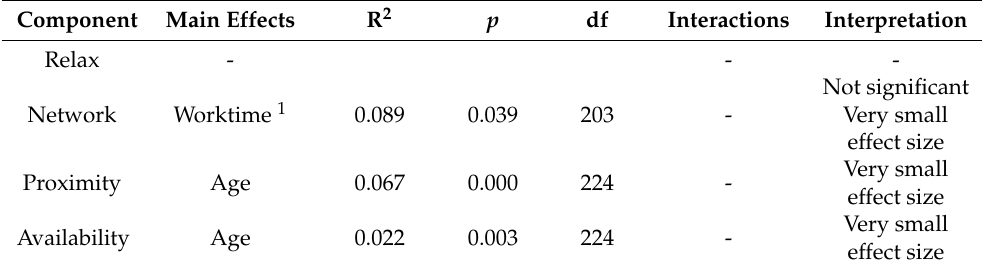
Table 9. Services—Linear regression.